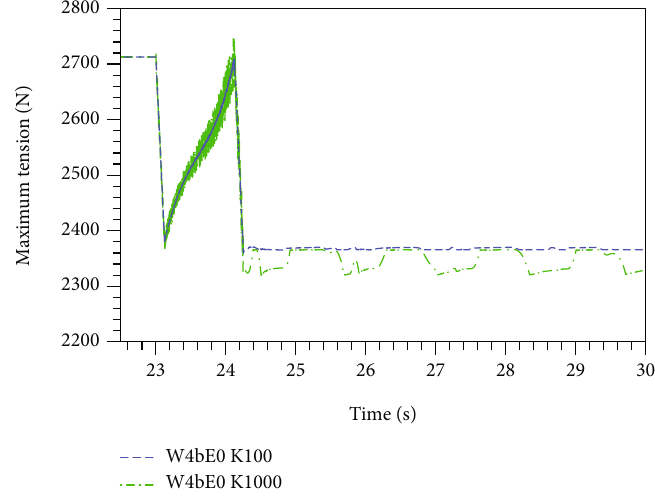
Figure 15: Case W4bE0-k tension histories with di ff erent k